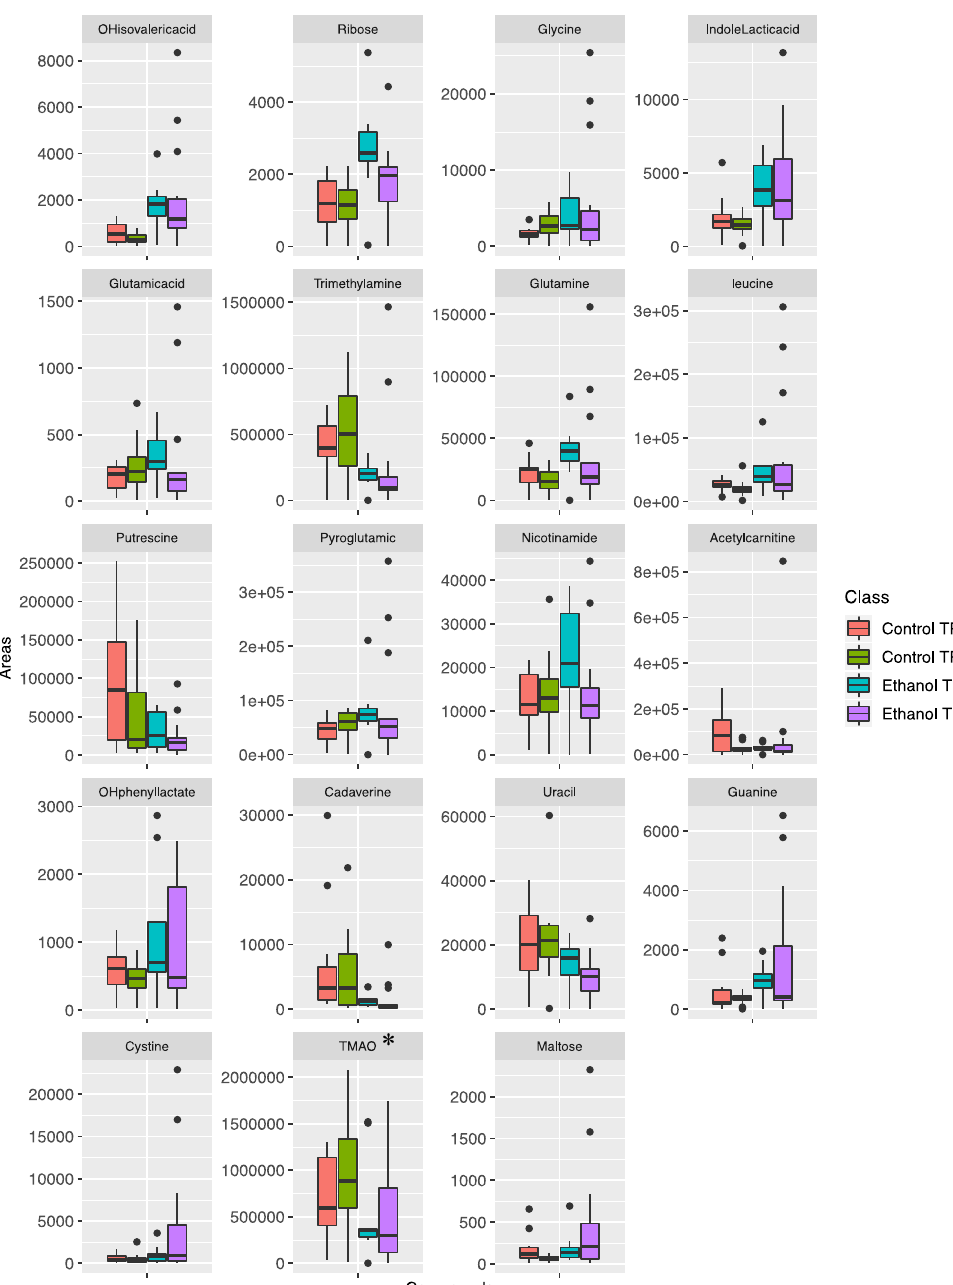
Figure 4. Box plots for the metabolites that were found to differentiate significantly in the urine samples of ethanol treated mice. * Trimethylamine-N-oxide.